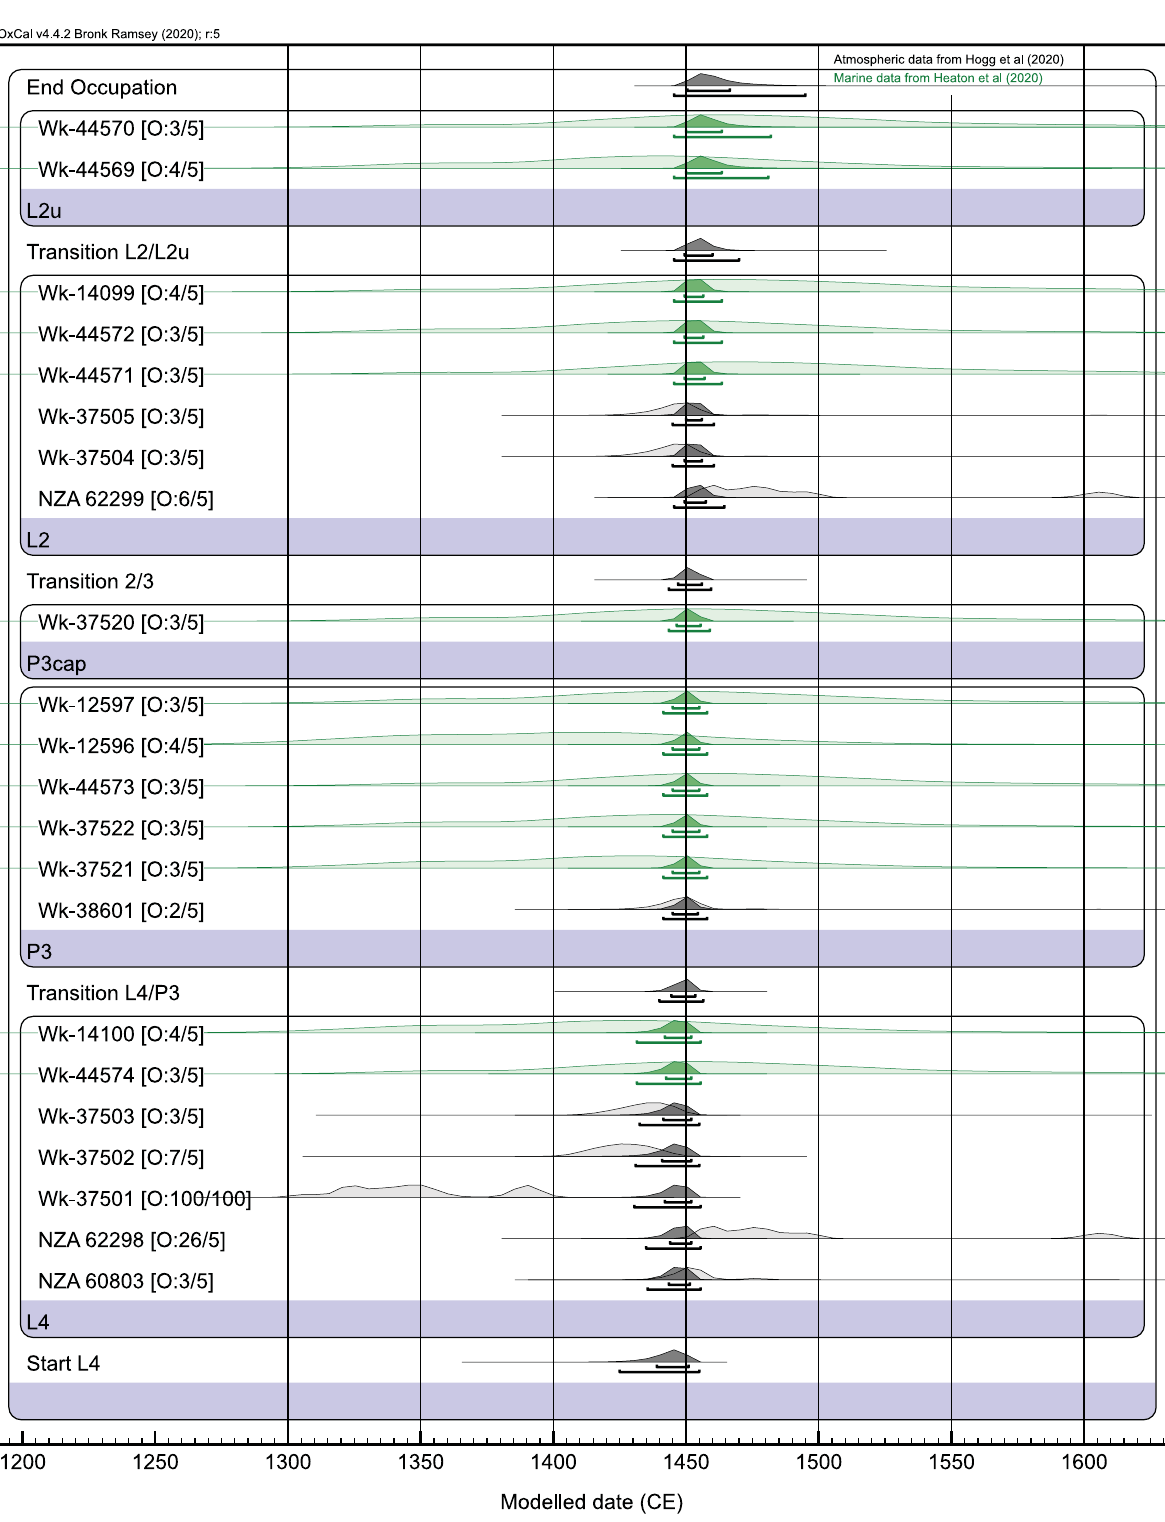
Fig 5. Bayesian chronological model for calibrated 14 C ages by phase from I44/21 S incorporating Outlier [O:] analysis in OxCal v. 4.4 (after model details, code and data in S2 Text and S2 Table). The model applies calibration curves SHCal20 and Marine20 [43,44], with the latter corrected for local reservoir variation using a weighted mean Δ R value from historic mollusc data (-162 ± 28) updated for Marine20 (S2 Text).